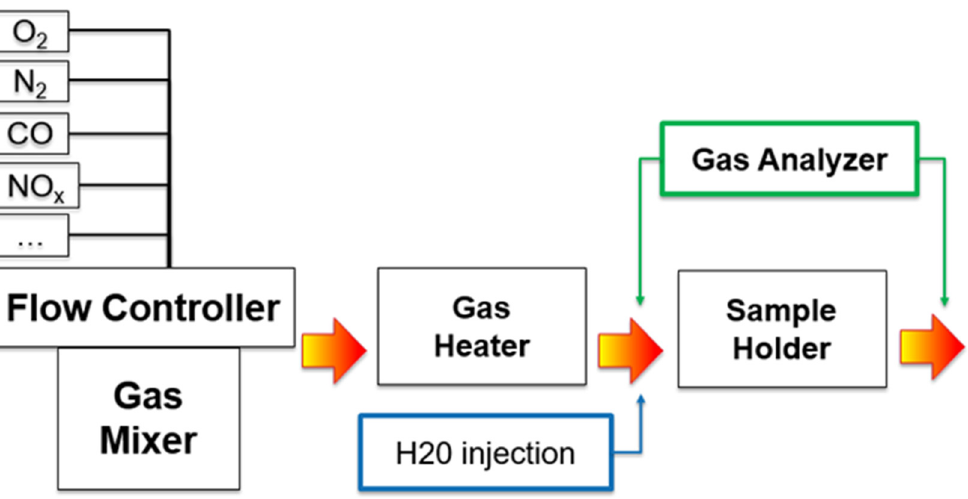
Figure 15. Scheme of the Synthetic Gas Bench (SGB).